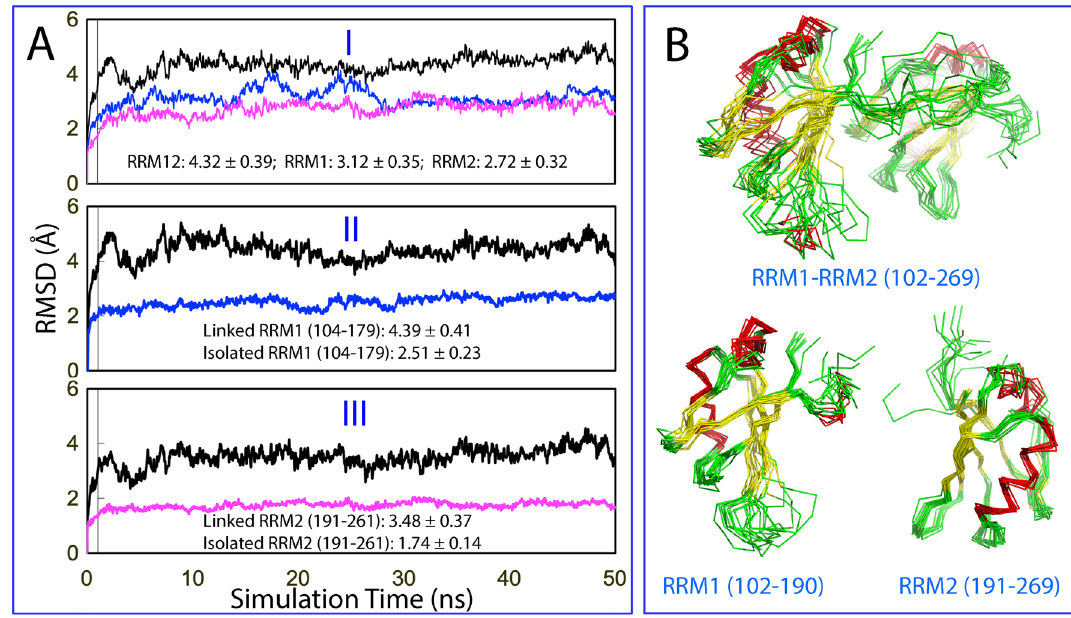
Figure 6. Overall dynamic behaviors of the TDP-43 RRM domains. ( A ) Average root-mean-square deviations (RMSD) of the Cα atoms over three independent 50-ns MD simulations for the tethered RRM1–RRM2 (black), as well as isolated RRM1 (blue) and RRM2 (pink) (I). For the RRM1 in the tethered form (black) and isolated form (blue) with the unstructured N- and C-termini excluded for calculation (II); as well as for the RRM2 in the tethered form (black) and isolated form (pink) with the unstructured N- and C-termini excluded for calculation (III). ( B ) Structure snapshots in the first MD simulation with one structure for each 5 ns. The image was prepared by PyMol2.4 (https ://pymol .org).